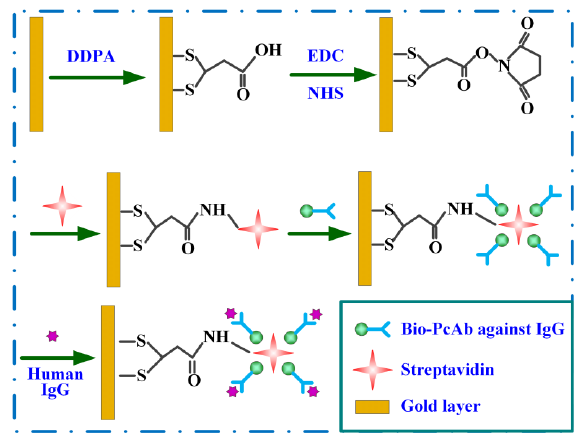
Figure 6. Schematic diagram of the functionalization processes on the polymeric sensing micro- cantilevers and IgG molecules binding with bio-PcAb against IgG.